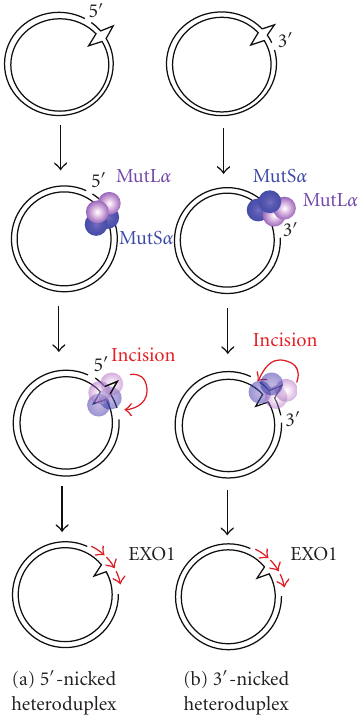
Figure 3: The 5 (cid:2) -nick-(a) and 3 (cid:2) -nick-(b) directed eukaryotic MMR. After recognition of a mismatched base by MutS α , MutL α incises the discontinuous strand of the heteroduplex in a mismatch- MutS α -, PCNA-, RFC-, and ATP-dependent manner [10, 30, 31]. Incisions by MutL α occur dominantly on the distal side of the mismatched base relative to the pre-existed strand break although it can also occur proximal to the mismatch